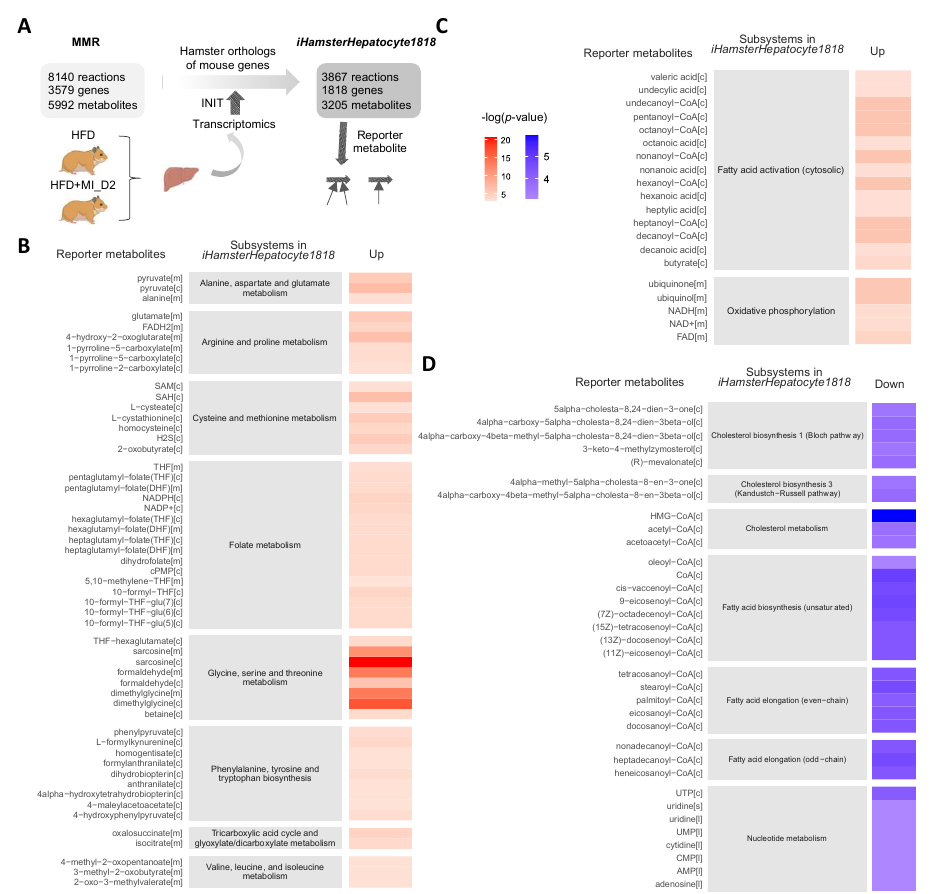
Figure 3. Reporter metabolites in CMA-treated group with Dose II. Metabolic differences between the hamsters treated with or without CMA at Dose II (HFD and HFD + MI_D2) were investigated through a comparative analysis of the gene expression profiles (RNA-seq) of the liver and iHam- sterHepatocyte1818 . ( A ) Liver-specific genome-scale metabolic model for Golden Syrian hamster ( iHamsterHepatocyte1818 ) was created using the Golden Syrian hamster orthologs of mouse genes based on the mouse metabolic reaction (MMR); ( B ) reporter metabolites associated with amino acid metabolism and tricarboxylic acid (TCA) cycle; ( C ) fatty acid activation and oxidation phosphory- lation; ( D ) biosynthesis and metabolism of cholesterol, biosynthesis and elongation of fatty acid, and nucleotide metabolism. p values for each reporter metabolite were calculated for up-and down- inference for tissue.